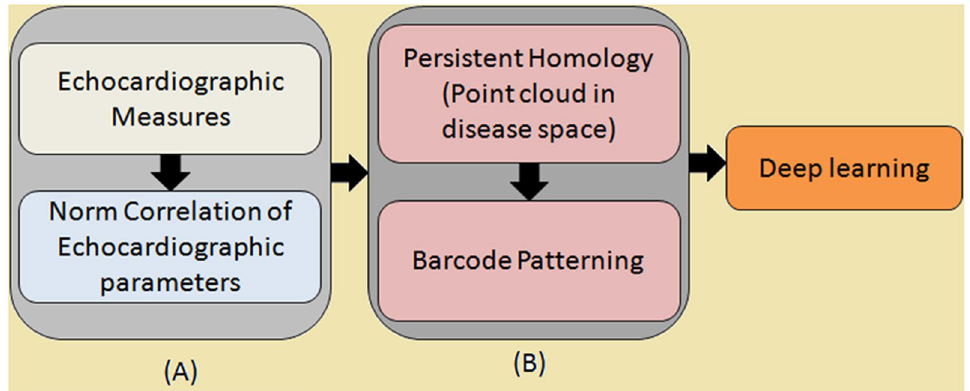
Fig. 7 Workflow for echocardiographic features on TDA network. a Normalized bivariate correlation matrix of the different echocardiographic parameters of the dataset. b TDA combines the compressed representation with expressive visualization and understanding using a persistence diagram and